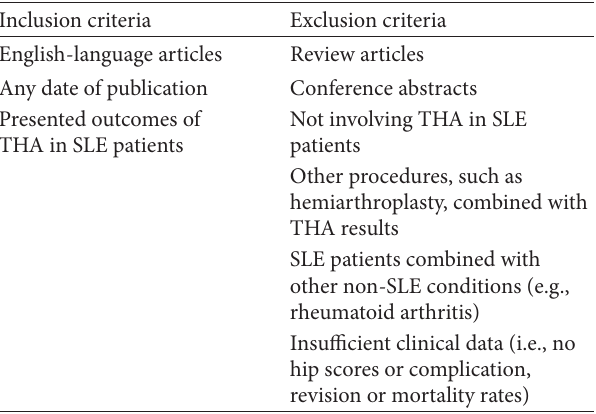
Table 1: Inclusion and exclusion criteria for